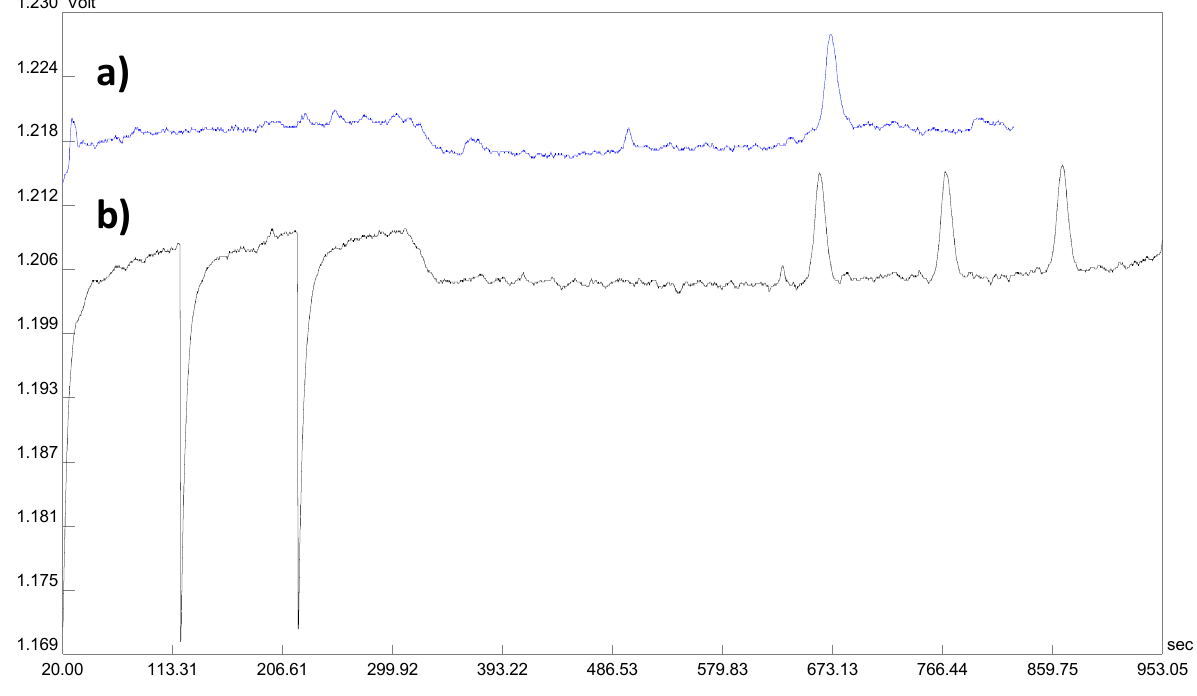
Figure 1. Illustrative electropherograms obtained from the analysis of ibuprofen standard at the LOQ concentration level 1.25 µg/mL under conventional single sample injection ( a ) and repeated sample injection ( b ). Table 2. Selected operation and calibration parameters of the CZE-UV method.